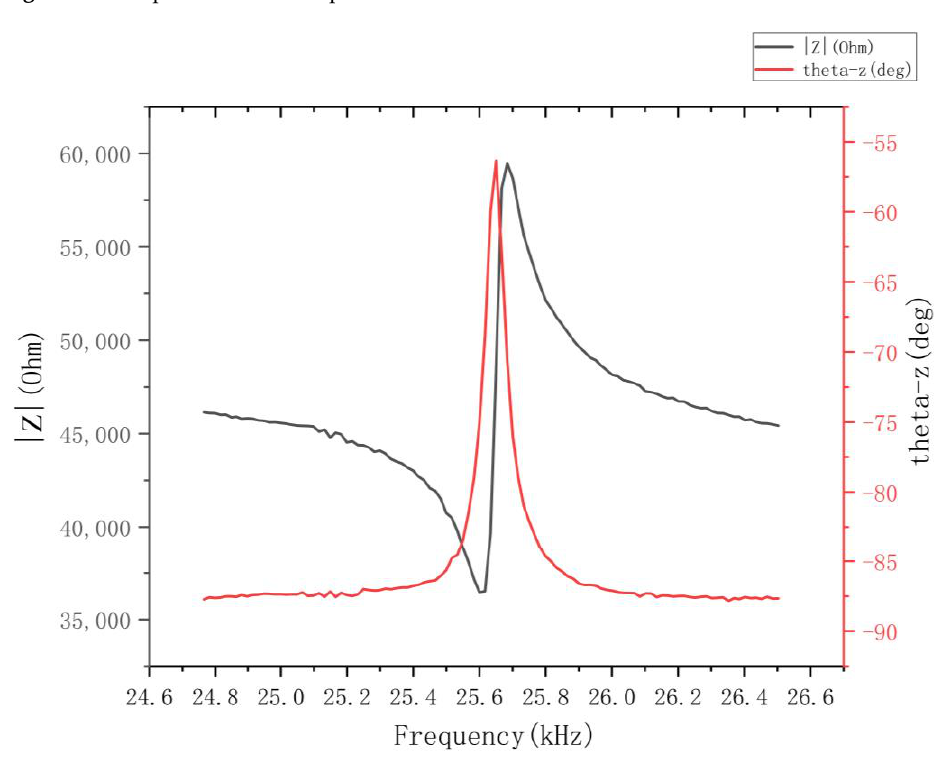
Figure 11. The platform of the experiment.